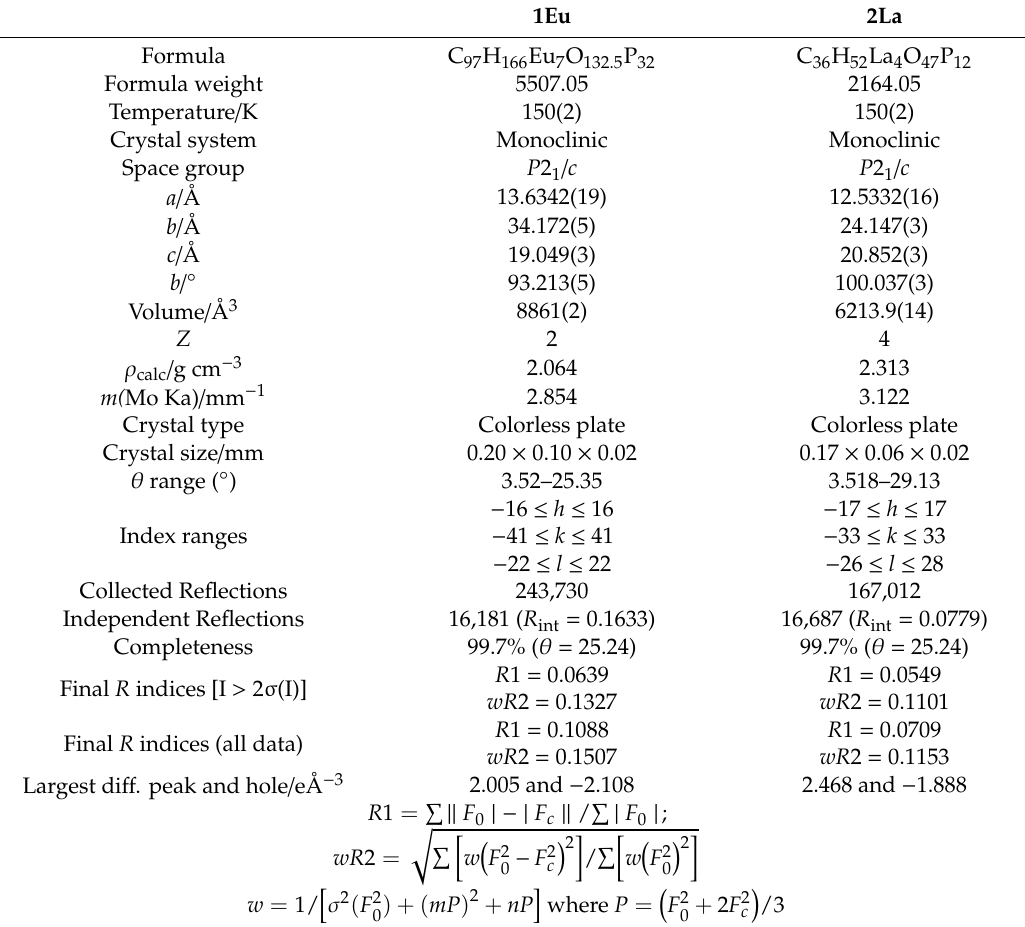
Table 1. Crystal data collection and structure refinement details for [Eu 7 (H 5 btp) 4 (H 5.5 btp) 2 (H 6 btp)